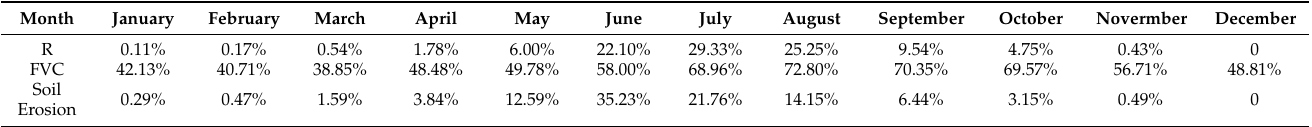
Table 7. Distribution of R, FVC and corresponding grassland soil erosion across the year.